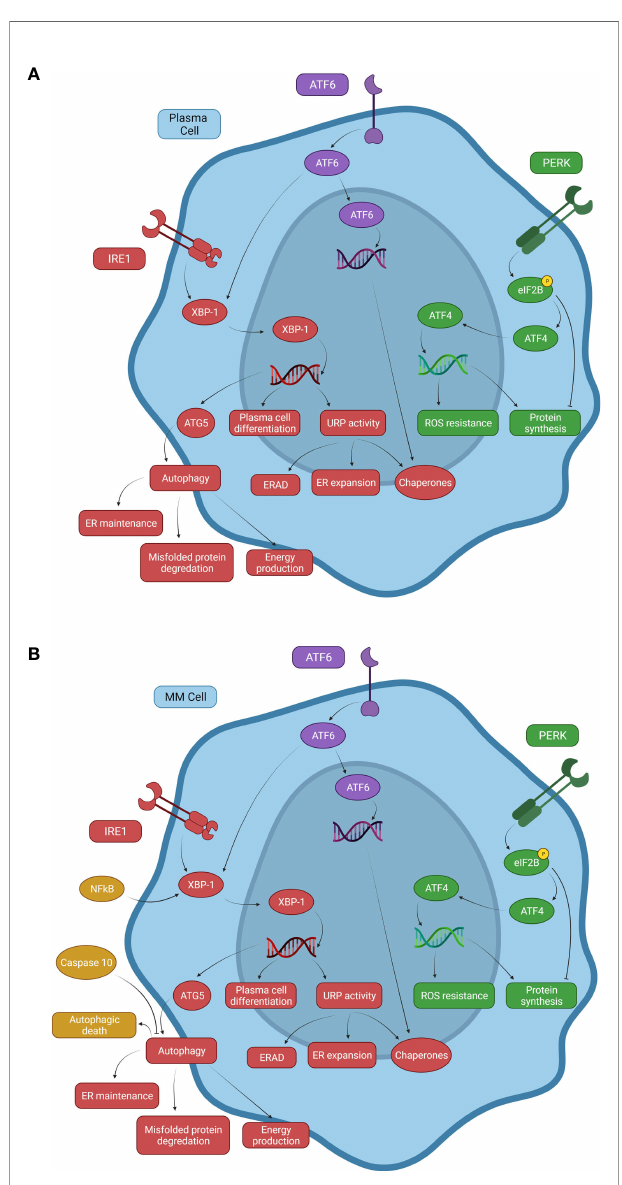
FIGURE 1 | Signaling mechanisms of the UPR system and autophagy in normal and malignant plasma cells. (A) Normal B cells and PCs use three primary pathways associated with the UPR that respond to proteasome stress. The PERK pathway inhibits eIF2B through phosphorylation to promote ATF4 expression, inducing transcription of ROS resistance genes. PERK causes both decreased and increased protein synthesis, but overall decreases protein synthesis. The ATF6 pathway can drive chaperone protein gene expression and XBP-1 activity in the IRE1 pathway. The IRE1 pathway increases XBP-1 activity, inducing expression of ATG5, an important factor involved in autophagy activation, linking the UPR with autophagy. (B) A representation of some of the changes to these systems in multiple myeloma. NFkB is constitutively activated in a signi fi cant proportion of MM neoplasms due to activating mutations. Elevated NFkB activity induces XBP-1 expression, promoting autophagy and uncontrolled B cell transformation to MM cells. Caspase-10 expression serves as a survival factor for MM cells by attenuating autophagy and preventing autophagic death due to cellular